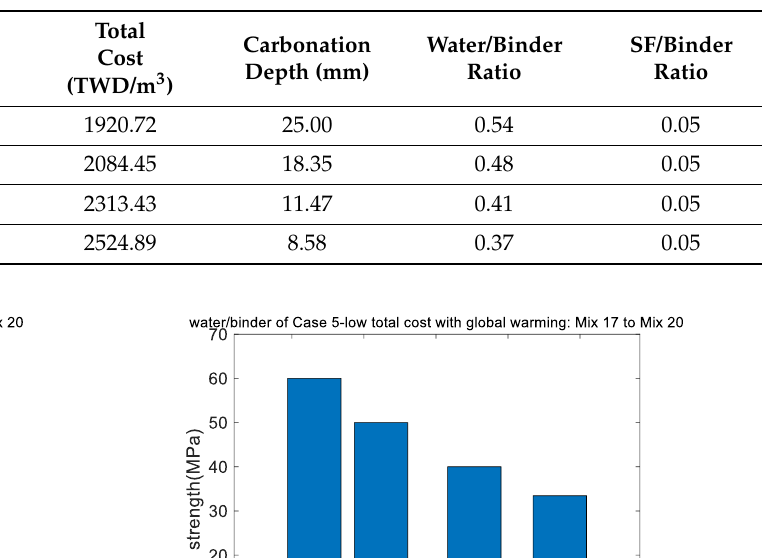
Table 14. Performance of optimal design mixtures for Case 5: low-total-cost concrete with global warming.